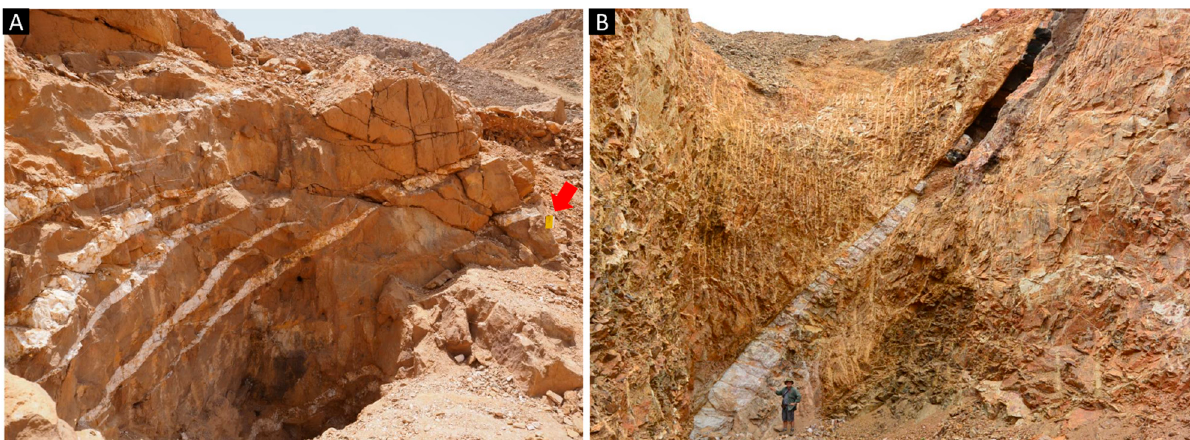
Figure 1. Typical aspect of orogenic gold-bearing quartz veins, with low sulfide content and a strong iron-carbonate alteration, inducing an orange tint to the host rocks. ( A ) Extensional, en echelon, low-dipping quartz vein network developed in a competent rock bordered by shear zones, New Rock mine, Sudan. Yellow field book (red arrow) as scale (20 cm). ( B ) Laminated quartz vein hosted in a reverse shear zone, Negeim mine, Sudan.